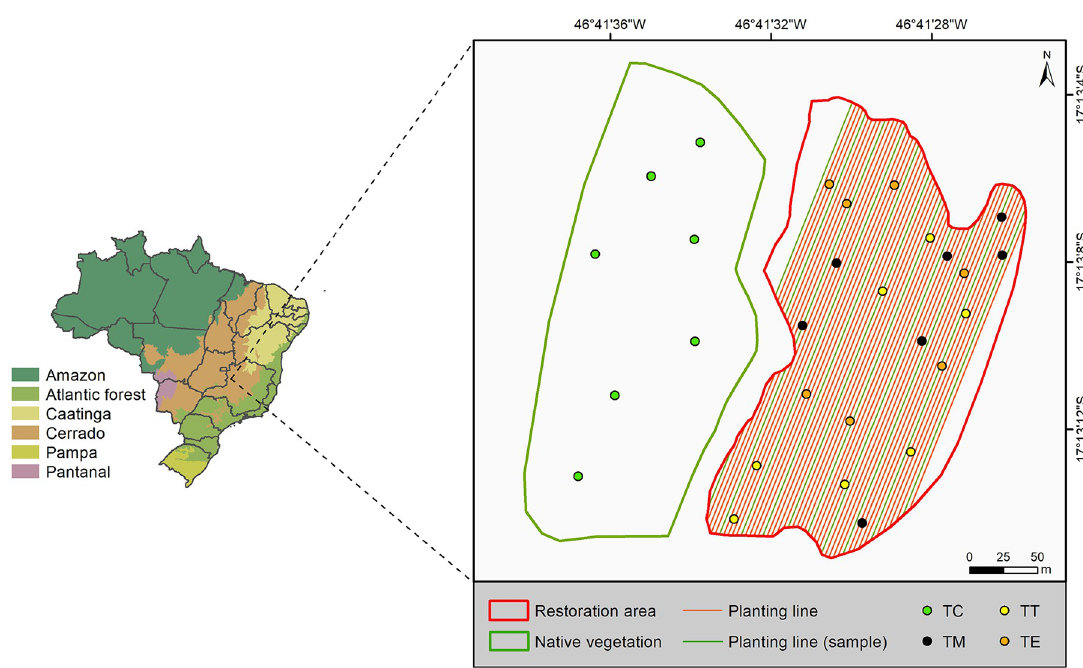
Fig 1. Map of the study area with respective planting lines and sample soil trenches. TC = Samples taken from the soil under Cerrado; TM = Samples taken from pits where seedlings did not survive; TT = Samples taken from T . guianensis pits; TE = Samples taken from the pits of C . pachystachya . Source: IBGE